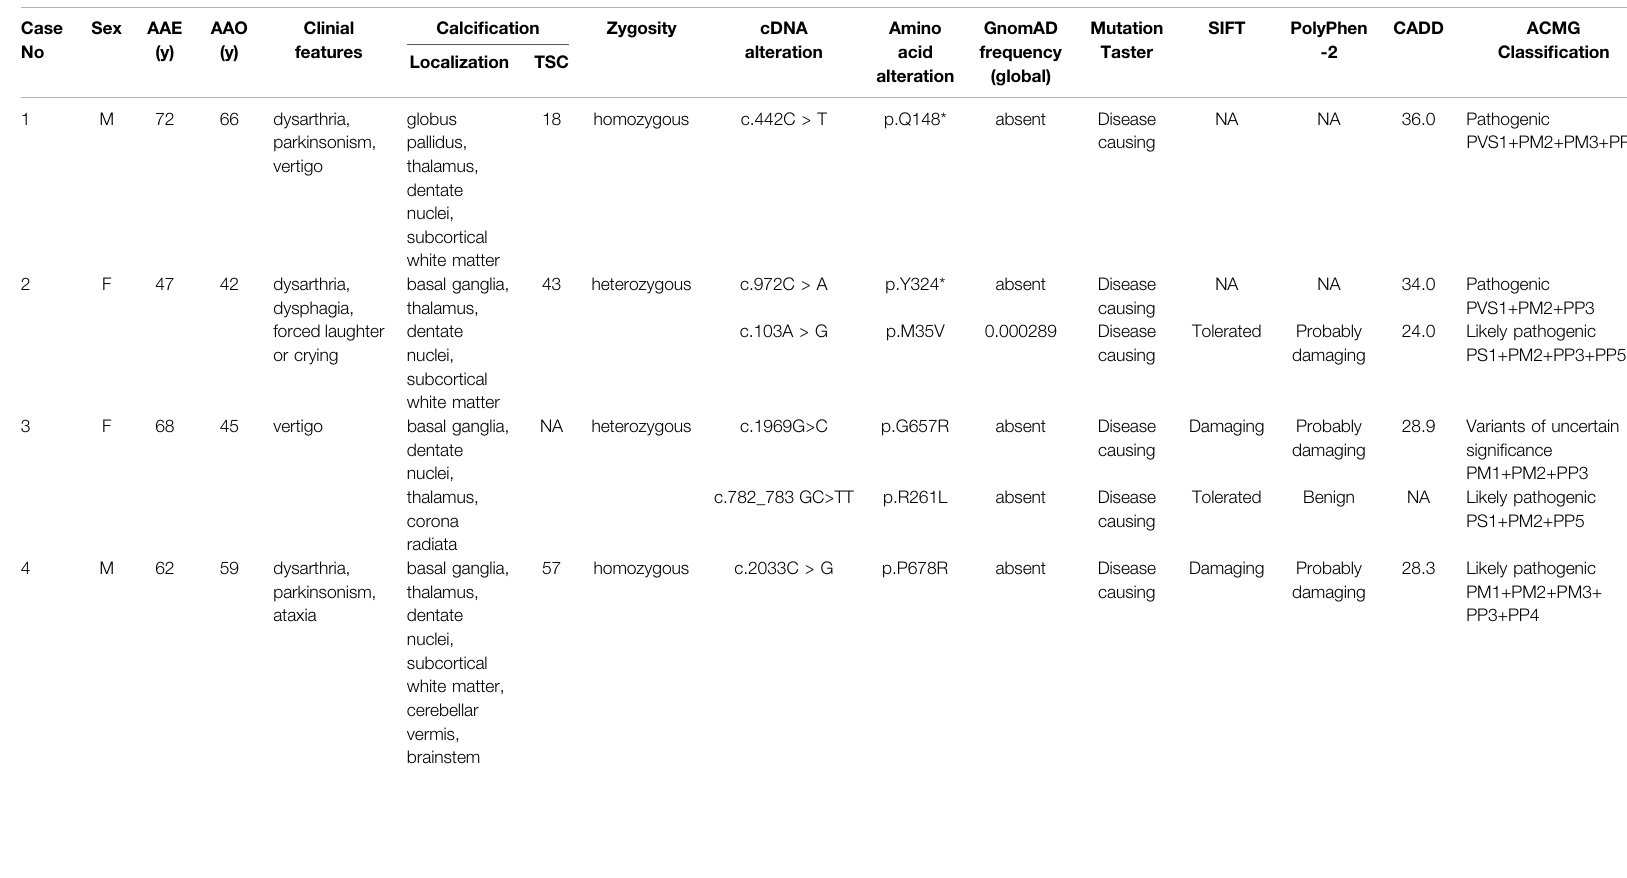
TABLE 1 | Clinical features in PFBC patients with MYORG mutations F, female; M, male; AAE, age at examination; AAO, age at onset; y, years; TCS, total calci fi cation score; NA, not